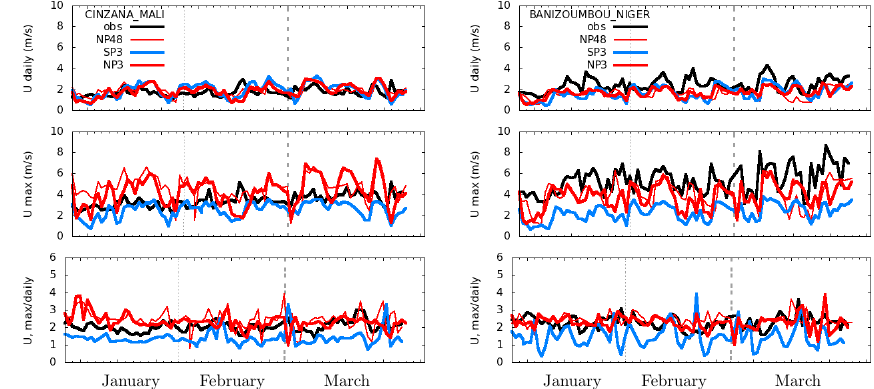
Figure 4. Time evolution over winter 2006 of the daily mean (upper panels) and maximum (middle panels) 10m wind speed (ms − 1 ) as well as the ratio (lower panels) of the maximum value to the daily mean for Cinzana (left) and Banizoumbou (right). Results of the SP3 (blue), NP3 (thick red line) and NP48 (thin red line) simulations are compared to site observations (black).